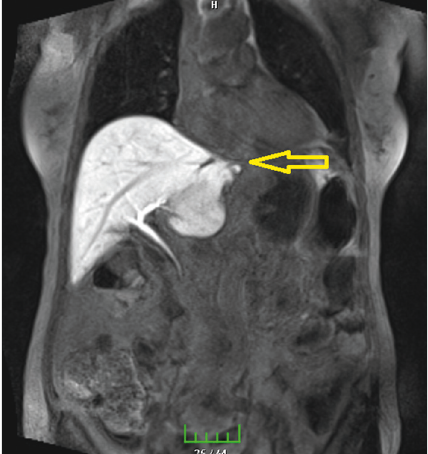
Figure 1: MRCP imaging. Bile leakage is shown in the left tri- angular ligament (appendix fibrosa hepatis).